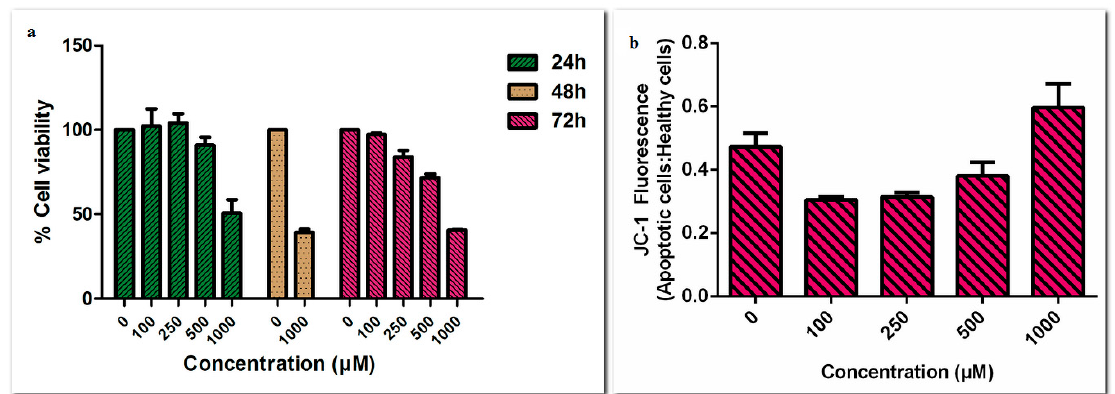
Figure 1. ( a ) Cell viability assay results following 24, 48 and 72 h incubations and ( b ) MMP assay results following 24 h incubation at high concentrations of etodolac (0–1000 μ M) in PC-3 cell line.